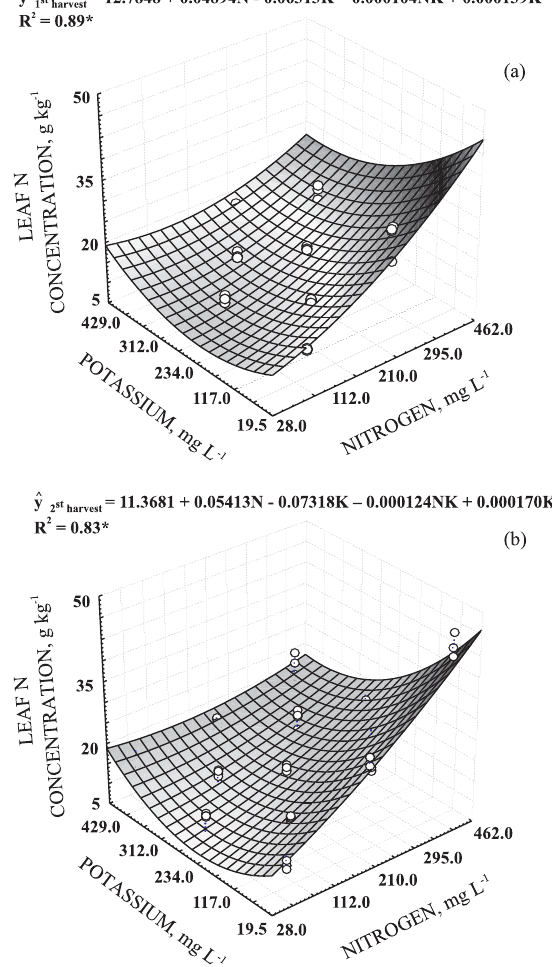
Figure 3. Leaf nitrogen concentration in the newly expanded leaf lamina (NL) of ‘Mombaça’ grass, in the first (a) and second (b) growths, related to N and K rates.